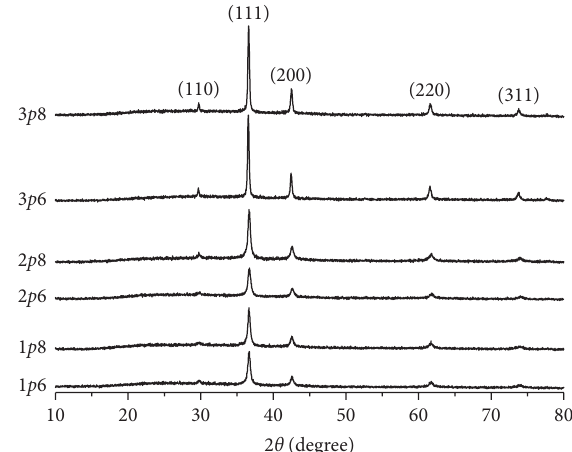
Figure 1: XRD patterns of Cu different